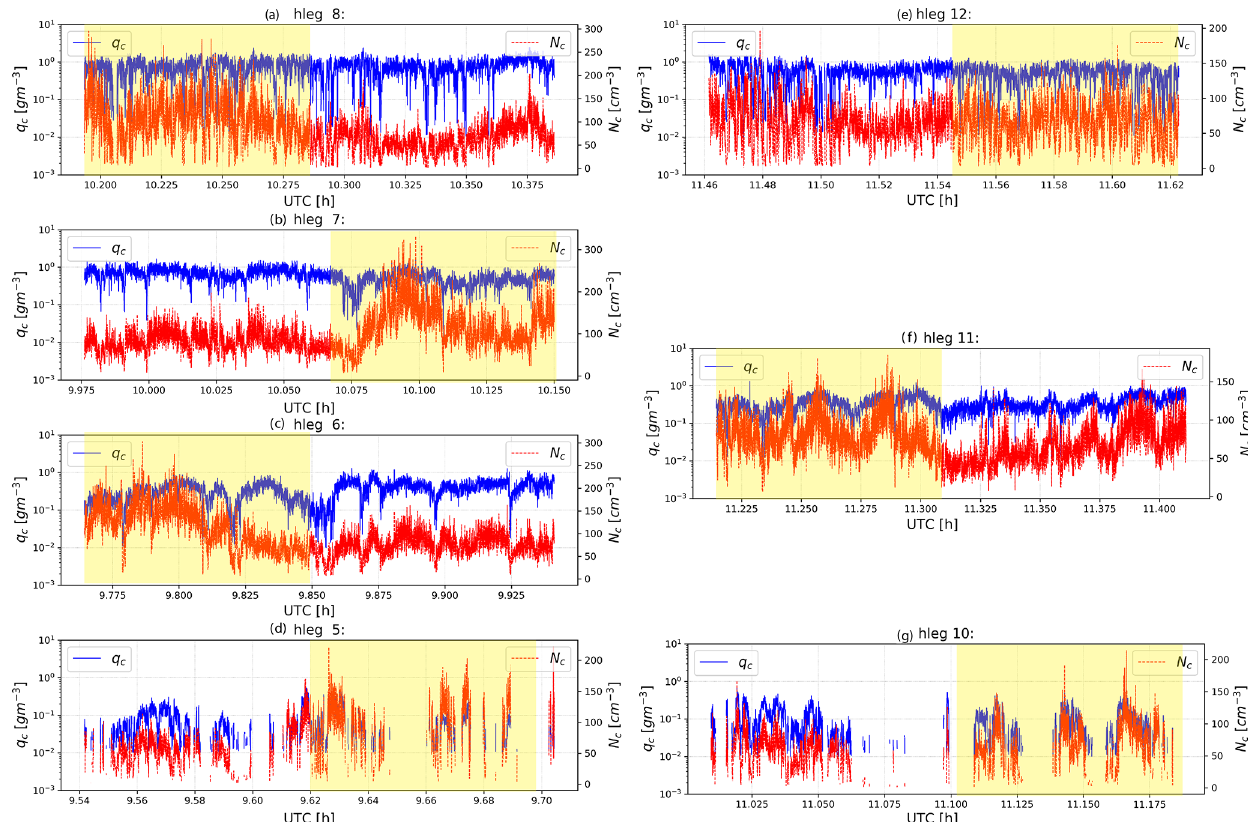
Figure 3. The horizontal variations of q c (red) and N c (blue) for each selected hleg derived from the in situ FCDP instrument. The yellow- shaded time period in each plot corresponds to the cross-wind side of the V-shaped flight track, and the unshaded part corresponds to the along-wind part. Note that plots are ordered such that (a) hleg 8 and (e) hleg 12 are close to cloud top; (b) hleg 6, (c) hleg 7, and (f) hleg 11 are sampled in the middle of clouds; and (d) hleg 5 and (g) hleg 10 are close to cloud